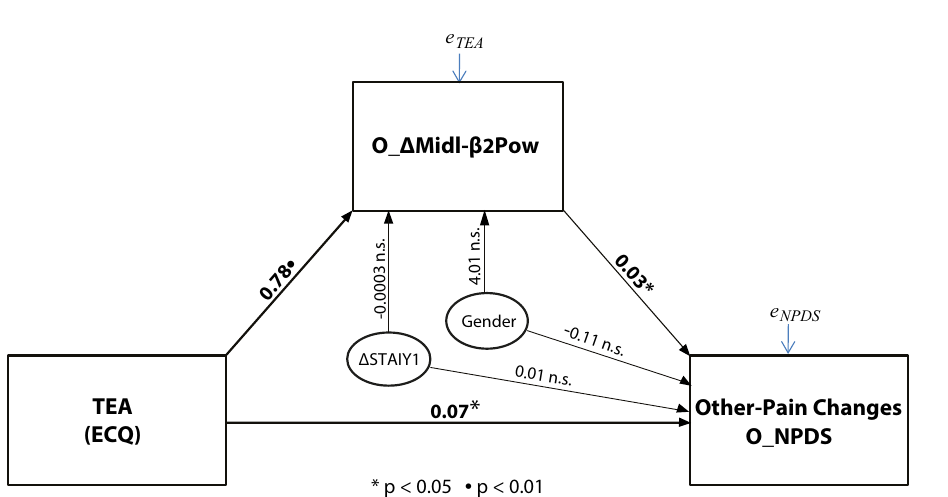
Figure 5. Simple mediator model testing the Total Empathy Ability trait (TEA) as the independent variable influencing other-pain changes (O_NPDS) through the mediation of midline β2 (22–32 Hz, 100–180 ms) power factor changes "O_∆Midl-β2Pow" induced by PA treatment in the other-pain condition. Direct and indirect effects (Ind) are reported. The thickness of the arrows indicates the strength of the link between variables. Gender and State-Anxiety changes (∆STAIY1) are entered as